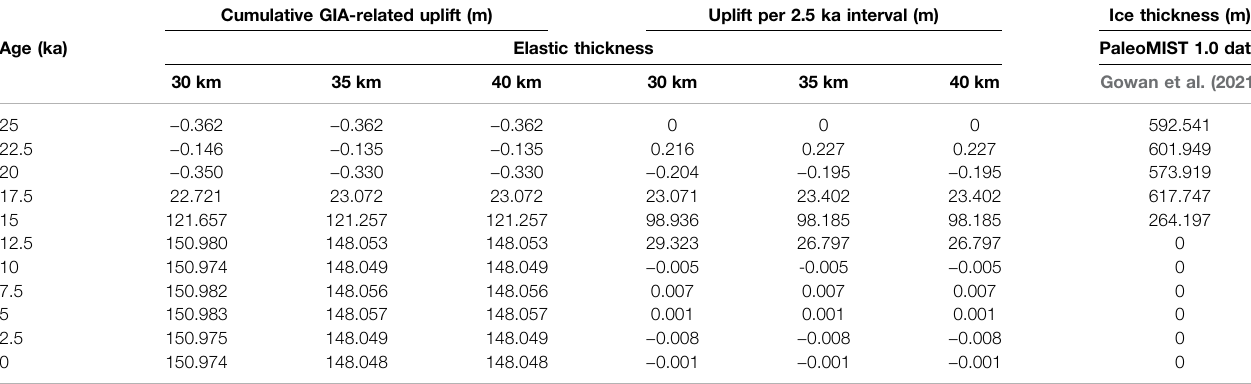
TABLE 4 | gFlex GIA-related surface elevation and PaleoMIST ice-thickness data. Cumulative GIA-related uplift (m) Uplift per 2.5 ka interval (m) Elastic